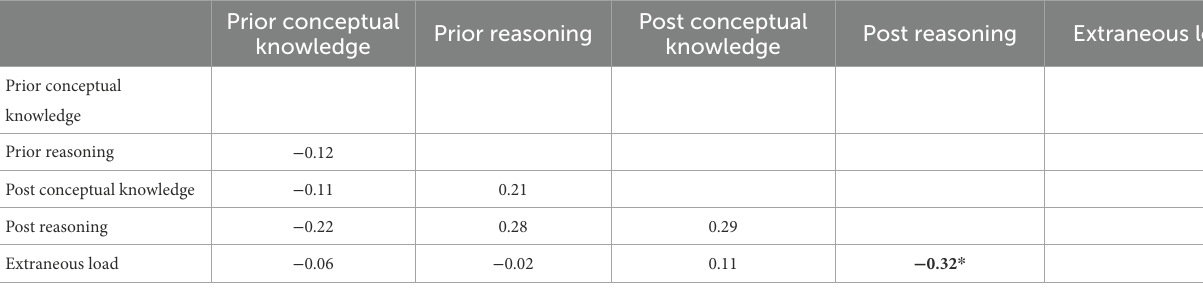
TABLE 6 Intercorrelations of relevant variables in Study 2b.